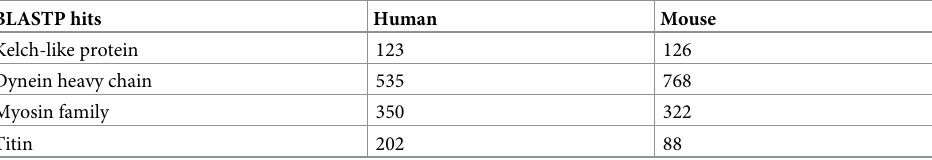
Table 5. List of most common hits from mouse and human peptides (from Fig 7). The Mayo monoclonals from Table 3 were tested on the 330K immunosignature array. 200 peptides that were common for the human and 200 pep- tides common for the mouse antibodies were used to compare the GeneBank human (hs) or mouse (mm) protein data- base using BLASTP and a cutoff of 0.01. The protein hits for each peptide were compiled and sorted. The table below contains proteins from both mouse and human that were hit at least 2-fold more often than the next most common protein. The first column lists the protein common name, the second column lists the number of times the 200 peptides aligned with each protein for human (column 2) and mouse (column 3). The next highest number of hits for human was 61 and for mouse was 47. BLASTP